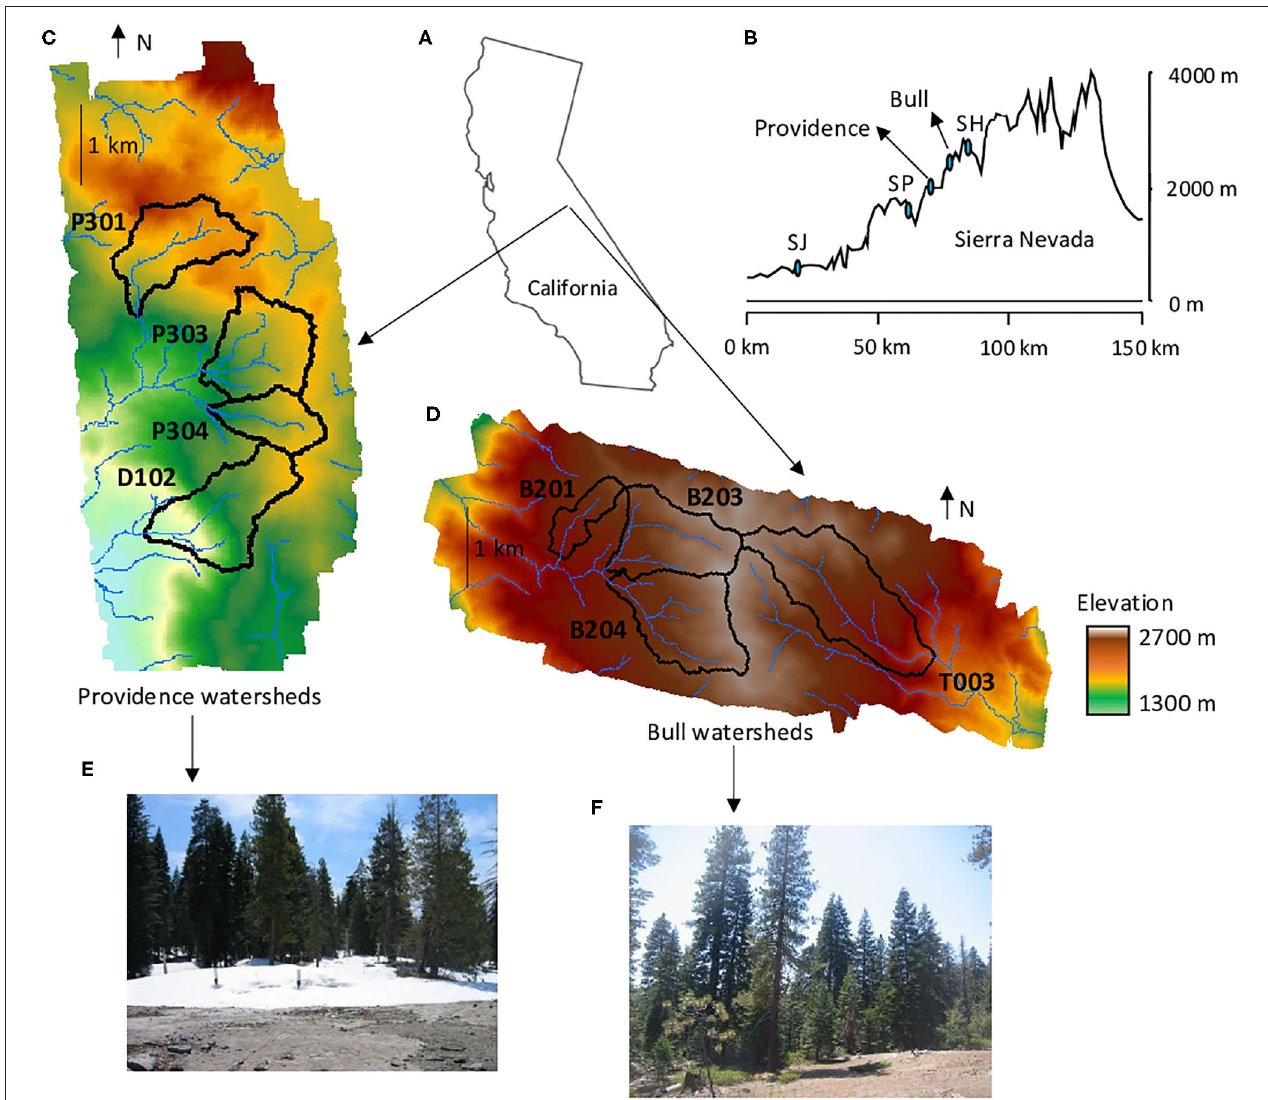
FIGURE 1 | (A) Providence and Bull watershed locations in California, USA. (B) West to East elevation transect from the San Joaquin valley over the Sierra Nevada, and showing SSCZO sites at the San Joaquin Experimental Range (SJ), Soaproot Saddle (SP) and Short Hair (SH). (C) Topographic map of the area